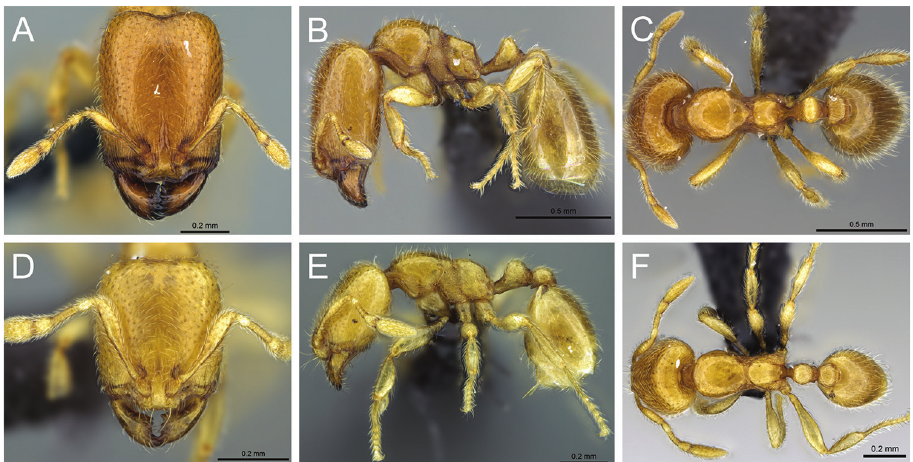
Figure 38. Carebara grandidieri . Major worker, CASENT0035958. A head in full-face view B body in profile view C body in dorsal view. Minor worker, CASENT0036011 D head in full-face view E body in profile view F body in dorsal